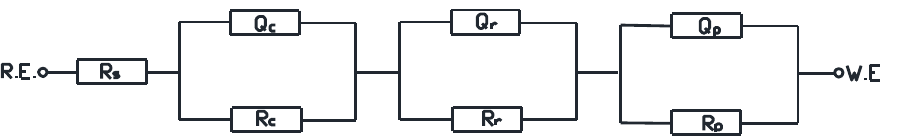
Figure 7. Equivalent circuit of the corrosion sensor embedded in the cement